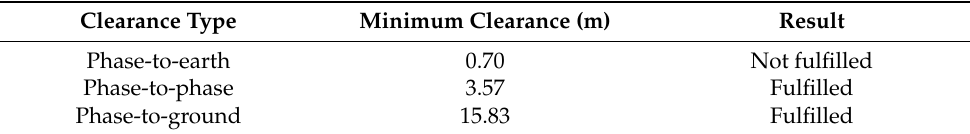
Table 3. Minimum electrical clearance of 132 kV steel lattice tower with 275 kV glass discs insulator.